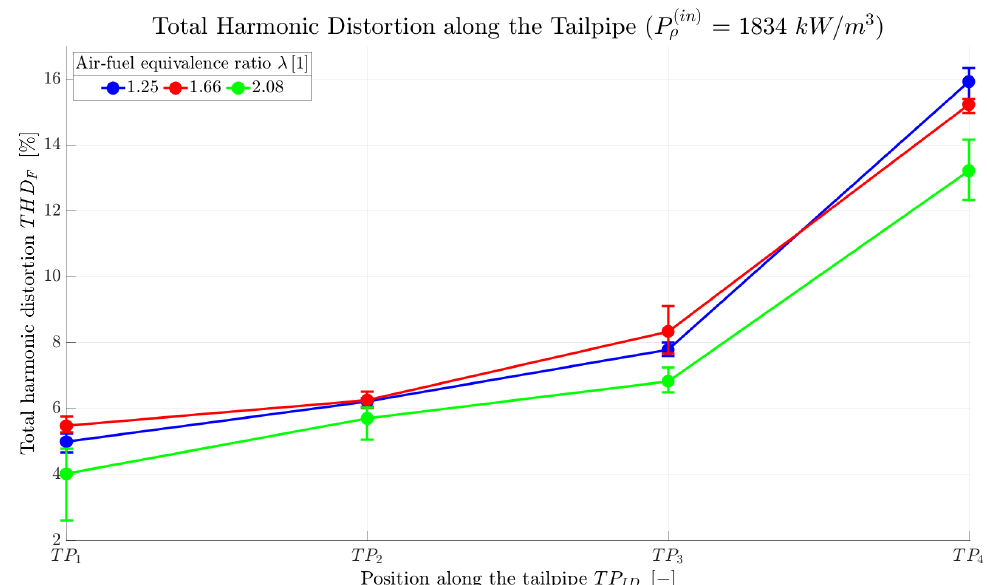
Figure 7. Total harmonic distortion along the TP for one specific power input density.